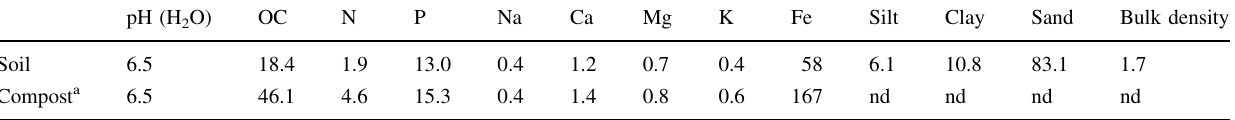
Table 1 Chemical characteristics of compost and soil (0–15 cm) used for the study Source: Dada and Aminu (2013) pH (H 2 O)